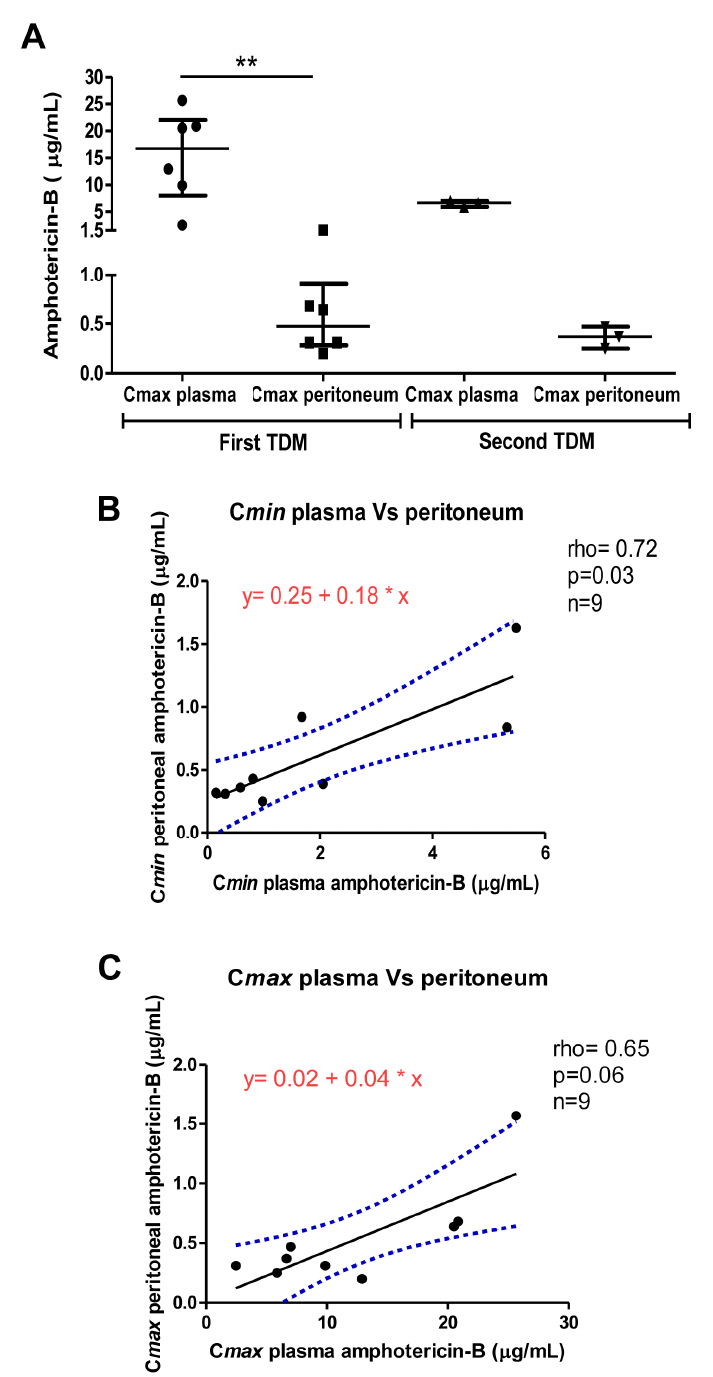
Figure 1. Evaluation of amphotericin-B levels in both plasma and peritoneum. ( A ) Comparison of amphotericin-B C max in plasma and peritoneal fluid. Data are expressed as median with interquartile range, ** p < 0.01; ( B ) Linear regression model with the best fit line (black) and 95% CI (dotted blue lines), describing correlation between amphotericin-B C min in plasma and peritoneum; ( C ) Linear regression model with the best fit line (black) and 95% CI (dotted blue lines), describing correlation between amphotericin-B C max in plasma and peritoneum. The asterisk (*) symbol indicates “times” the values on the X